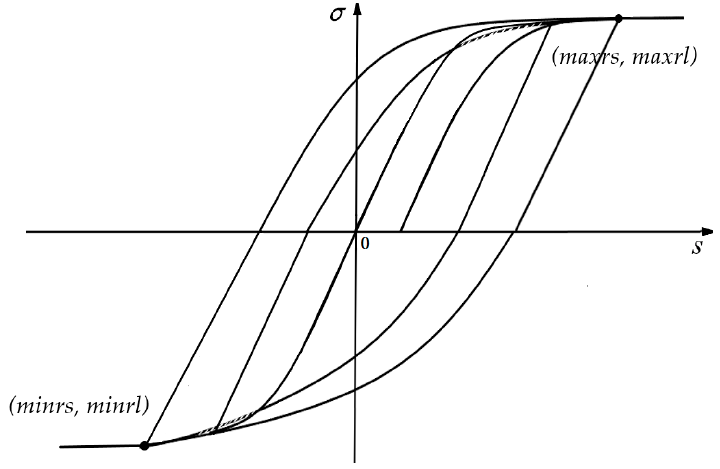
Figure 3. Hysteretic model schematic diagram for the bar stress vs. loaded-end slip relationship.